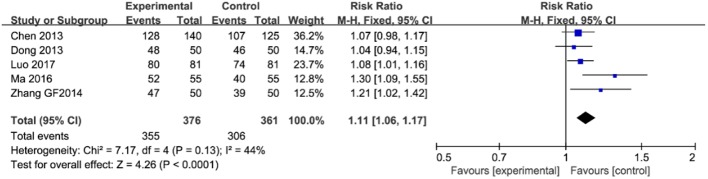
The pooled effects of berberine-containing quadruple therapy on relieving rate of clinical symptoms. Forest plot comparing berberine-containing quadruple treatment with the standard triple therapy.